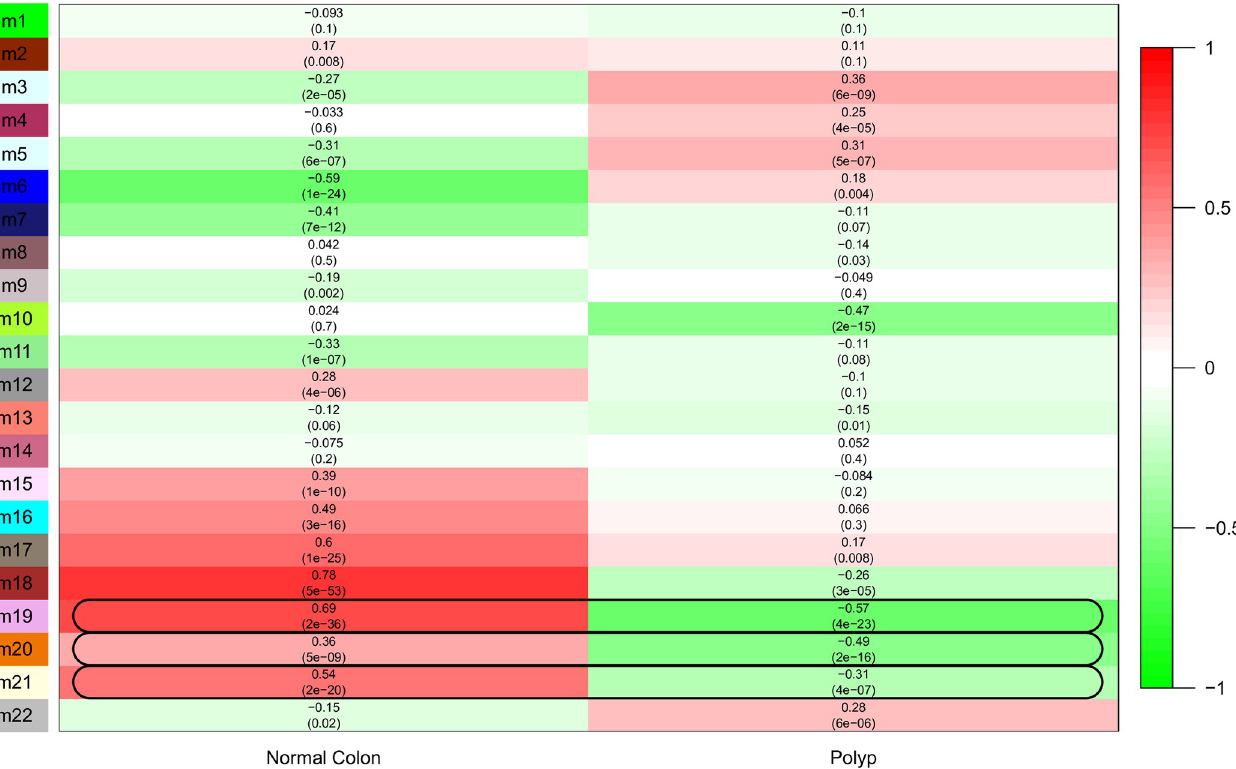
Fig 3. Correlation matrix resulting from WGCNA applied on the training dataset. Here, each cell indicates the Pearson correlation and p- value resulting from the association between the respective module eigengenes (row) and phenotype (column).